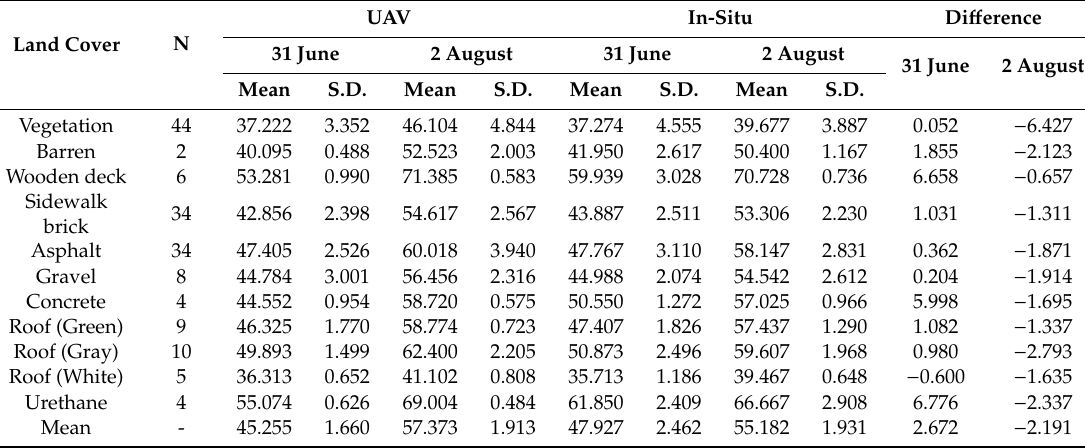
Table 2. UAV TIR LSTs and in-situ LSTs by land cover